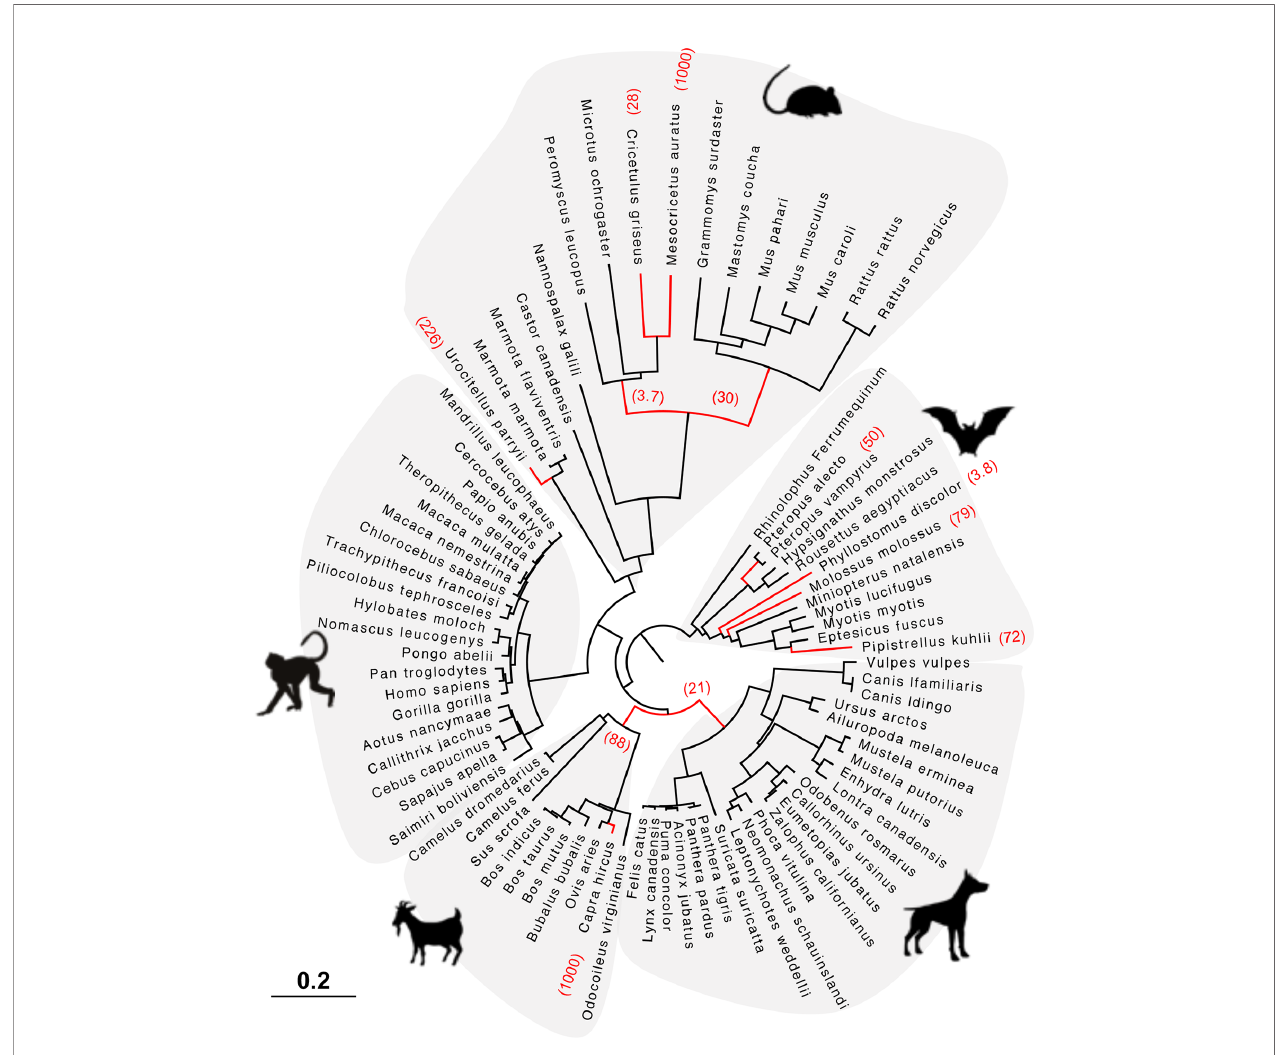
FIGURE 5 | HERC6 has been under strong positive selection during rodent and bat evolution. Maximum likelihood phylogenetic tree of mammalian HERC6 gene showing the branches under signi fi cant positive selection (p-value <0.05, in red) assigned by aBSREL from the HYPHY package. The numbers in brackets indicate the estimated values of the w at the branch. The scale bar indicates the proportion of genetic